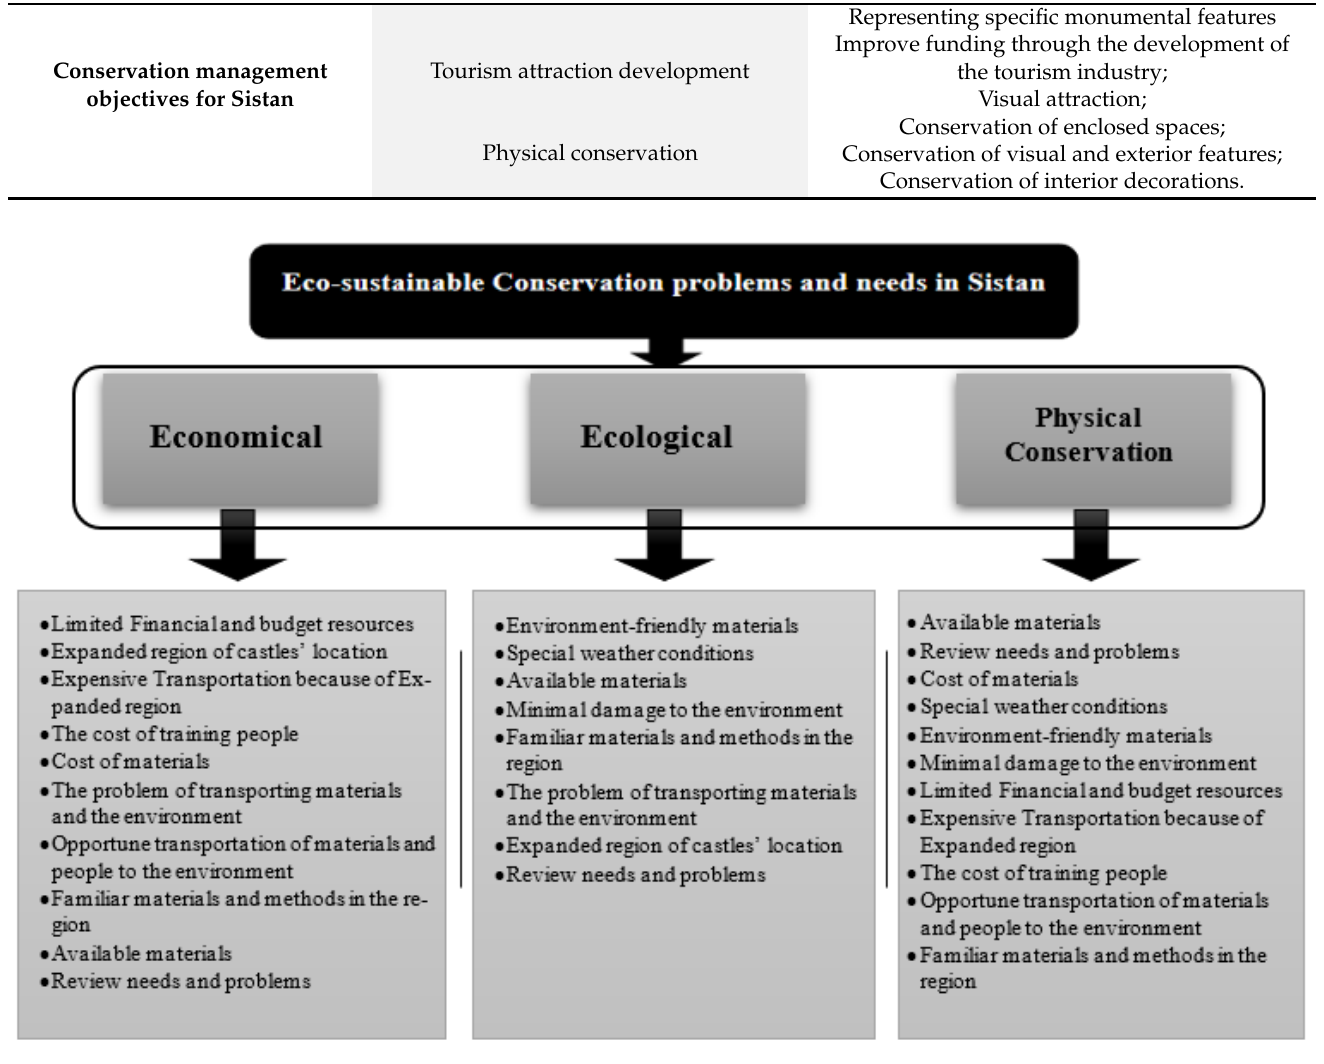
Figure 2. Eco-sustainable conservation problems and needs in Sistan.